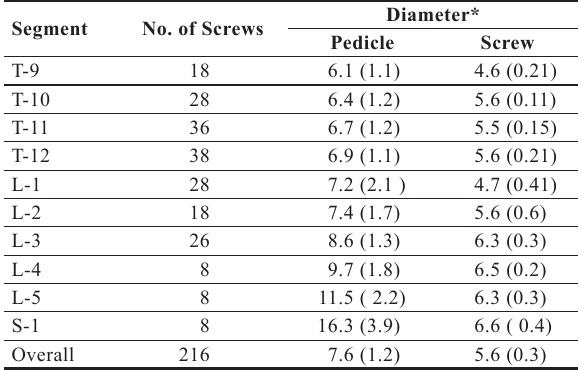
Table 1. Pedicle and screw